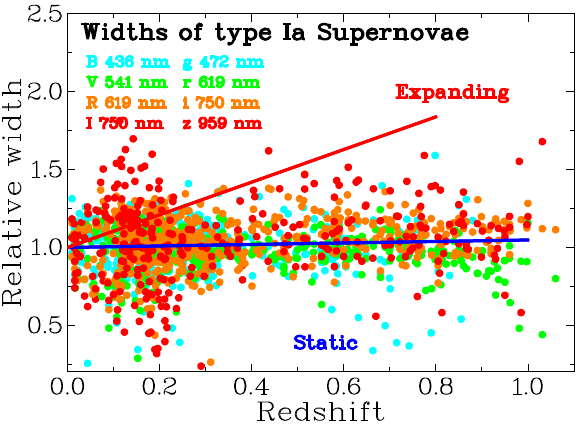
Figure 2. Plot of the measured width for the light curve for each supernova and filter a function of redshift. The blue line shows the regression line given in equation 8 and the red line shows the expected width ( w = 1 + z ) if there was time dilation. The legend shows the plotted color for each